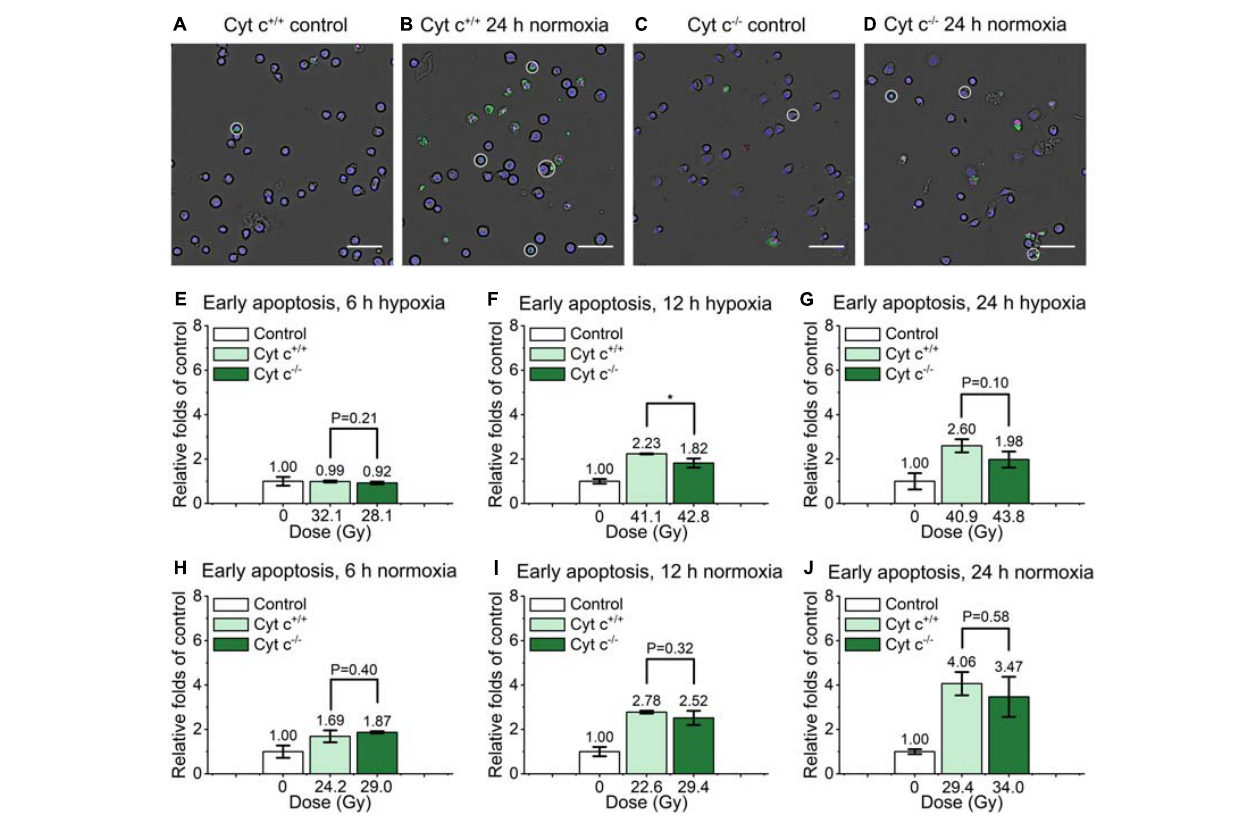
FIGURE 5 | Comparison of early apoptosis between irradiated cyt c + / + and cyt c − / − cells after FLASH irradiation. (A–D) Representative images of cyt c + / + control (A) , cyt c + / + irradiated (B) , cyt c − / − control (C) and cyt c − / − irradiated cells (D) at 24 h in normoxic condition. Early apoptotic cells were marked with white circles. Scale bars: 100 µ m. (E–J) The relative increasement of early apoptosis for irradiated cyt c + / + and cyt c − / − cells at 6 h in hypoxia (E) , 6 h in normoxia (H) , 12 h in hypoxia (F) , 12 h in normoxia (I) , 24 h in hypoxia (G) and 24 h in normoxia (J)